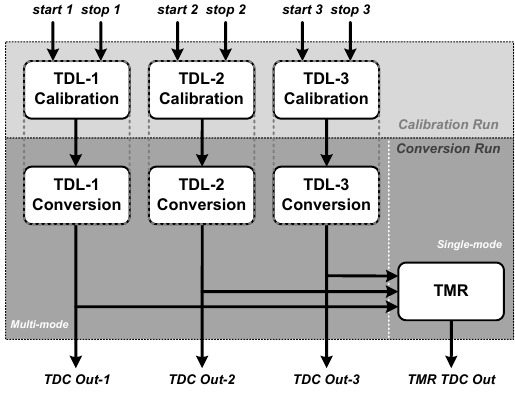
Figure 5. Operation flow of the proposed triple-TDC.